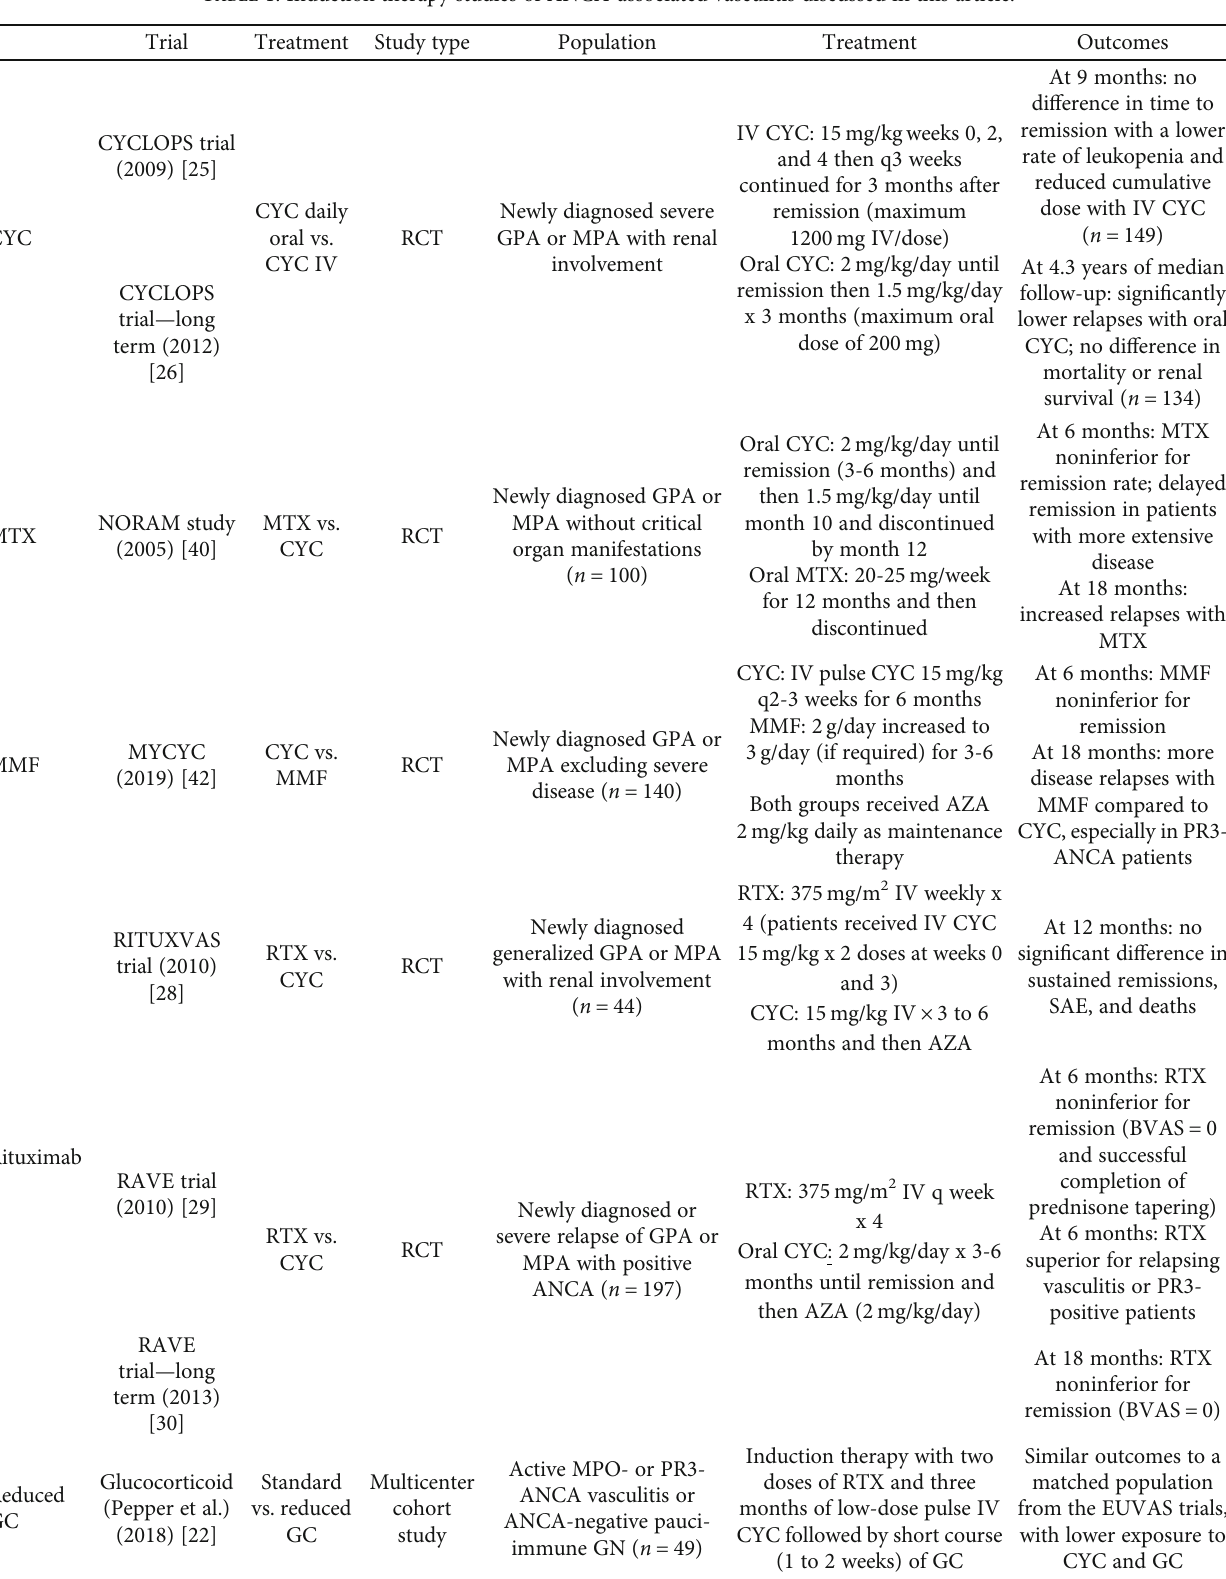
Table 1: Induction therapy studies of ANCA-associated vasculitis discussed in this